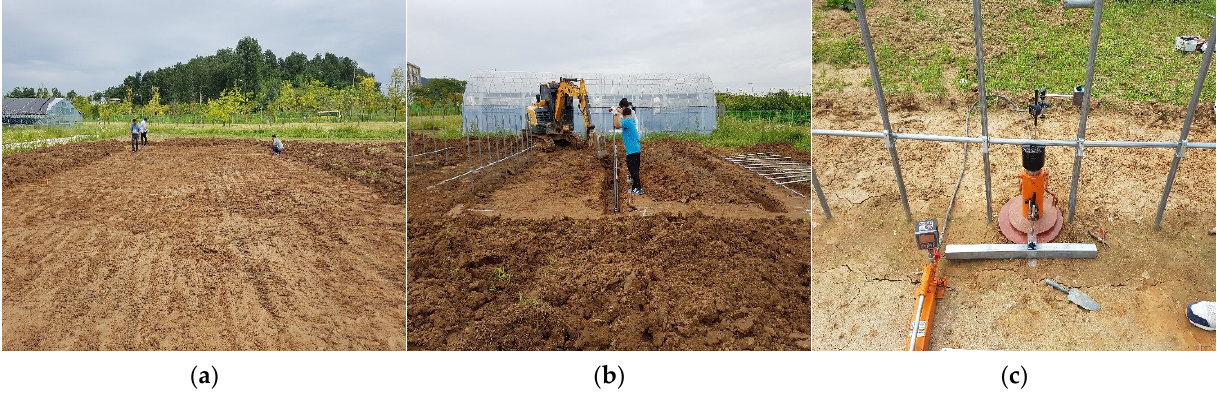
Figure 5. Field test procedure of site B: ( a ) ground grading work; ( b ) embedded depth leveling; ( c ) uplift testing of continuous foundations.